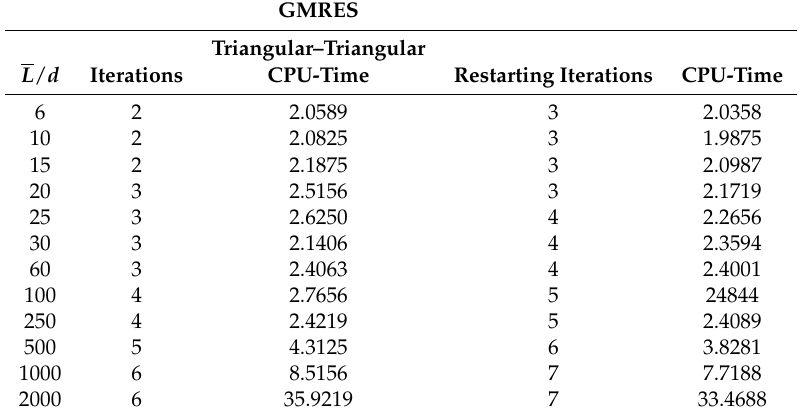
Table 5. GMRES: CPU-time (s) and #iterations for triangular–triangular basis-testing functions as L changes. d